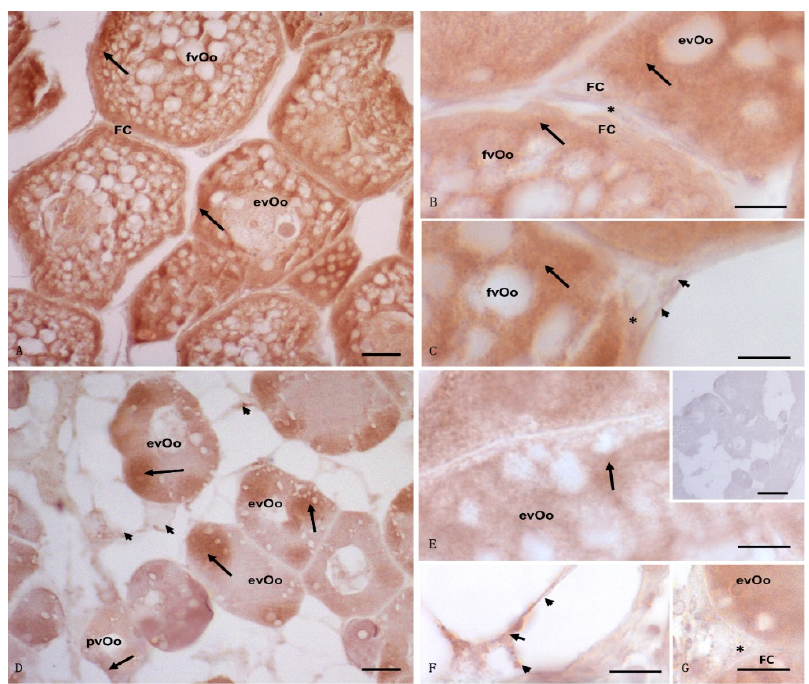
Figure 4. Light micrographs of Anguilla anguilla ovaries from control ( A – C ) and exposed specimens ( D – F ). Immunolabeling with anti-17 β -HSD antibody. ( A – C ) a wide and strong positive reaction was present in fully vitellogenic oocytes (fvOos) and early vitellogenic oocytes (evOos); a weak signal was evident in the follicular (FCs) and theca (asterisk) cells as well as in the connective cells (arrowheads). ( D – G ) early vitellogenic oocytes (evOos) were immunolabeled, and the signal was in some areas of the cytoplasm as spots (arrow); meanwhile, weak positivity (arrow) was localized within previtellogenic oocytes (pvOos), follicular (FC), and connective cells (arrowheads). No signal was evident in the theca cells (asterisk). ( E insert ) negative control: no labeling was evident in the ovary. Bars: ( A ) = 20 µm; ( B , C , E – G ) = 5 µm, ( D ) = 50 µm, ( E inset ) = 100 µm.